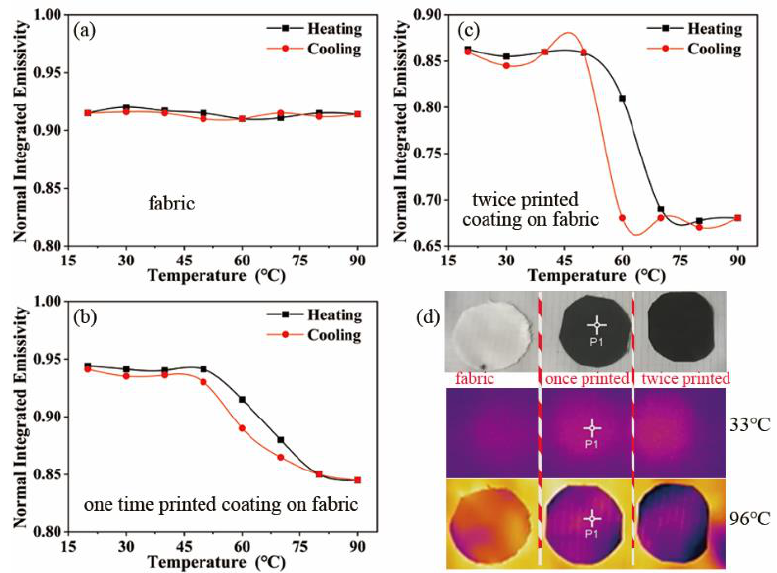
Figure 6. ( a ) Emissivity of polyester base fabric at different temperatures; ( b ) emissivity of once-printed coatings at different temperatures; ( c ) emissivity of twice-printed coatings at different temperatures; ( d ) from top to bottom, the image presents the optical image, and normal-temperature and high-temperature thermal infrared images.